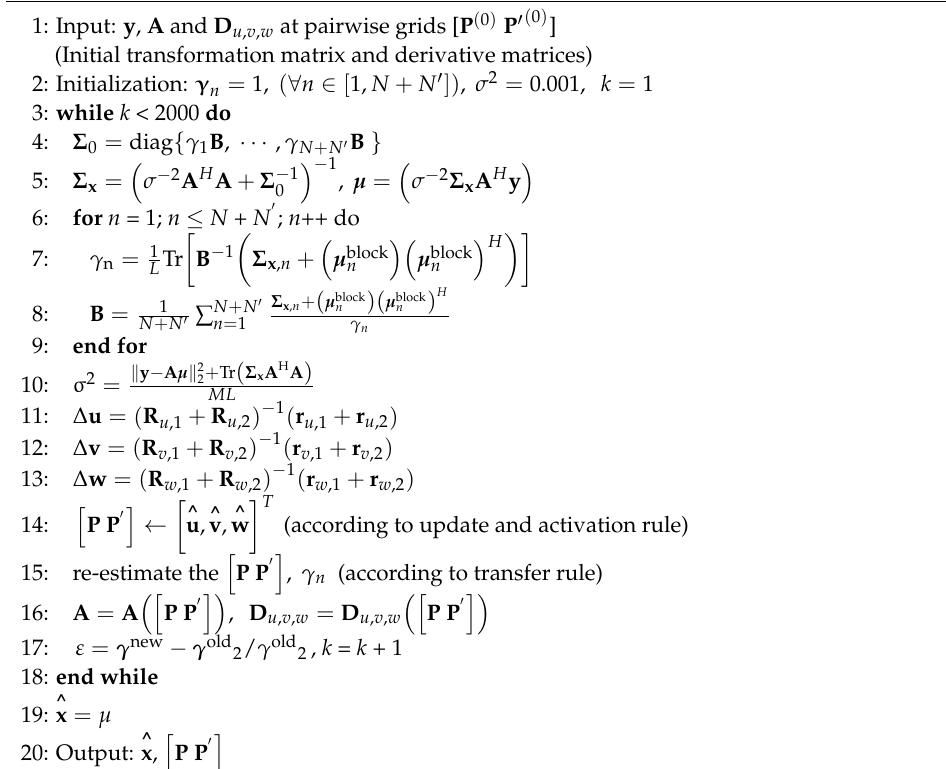
Algoritm 1. 3D pairwise off-grid cavitation localization